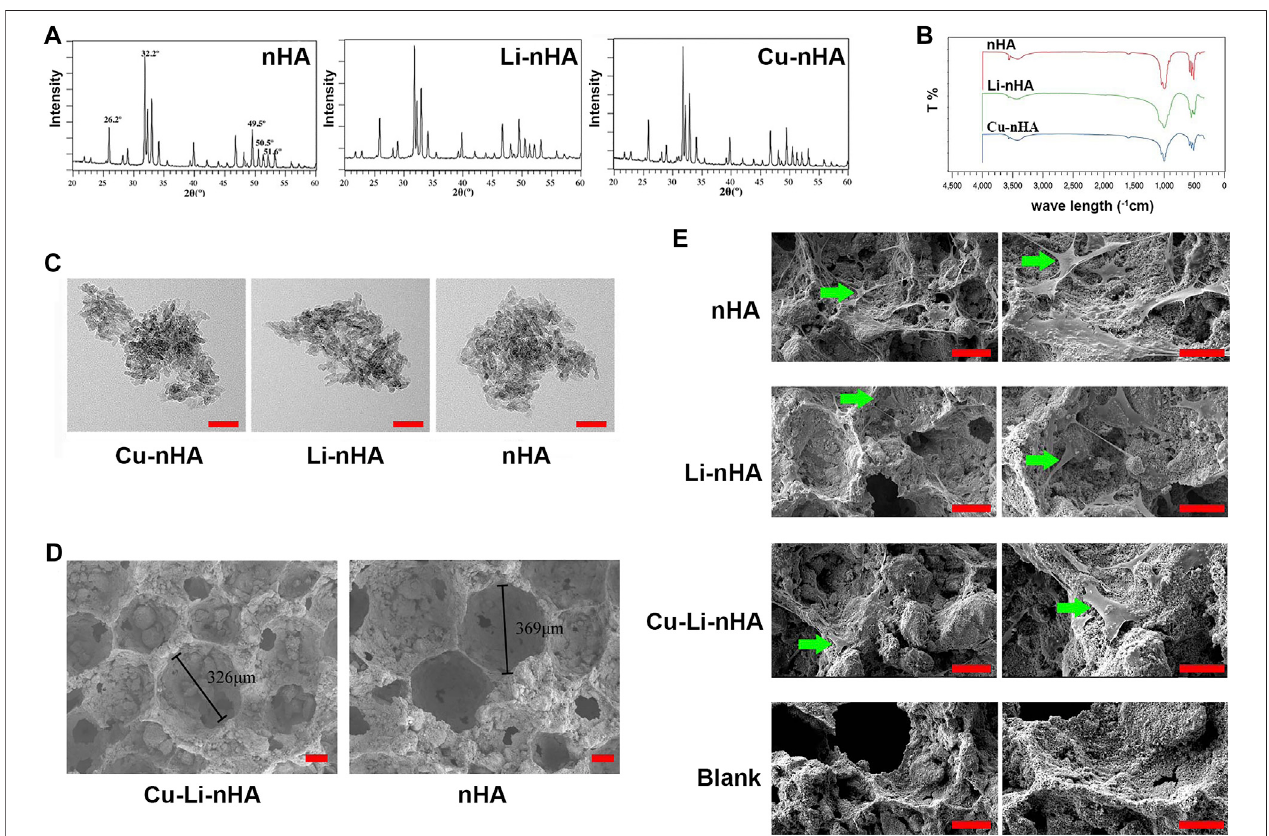
FIGURE2|(A) XRDspectrum. (B) FITRspectrum. (C) TEMobservation for particle size.Scale bar inthebottom right-hand corner ofeach image(red): 50 nm. (D) SEM observation for porous scaffold structure. Pore size is shown in each image. Scale bar in the bottom right-hand corner of each image (red): 100 μ m. (E) SEM observation for BMSCs adhesion to scaffolds. Blank Group: nHA without BMSCs co-culture. Green arrow: adherent BMSCs. Scale bar in the bottom right-hand corner of each image in the left column (red): 100 μ m; Scale bar in the bottom right-hand corner of each image in the right column (red): 50 μ m.